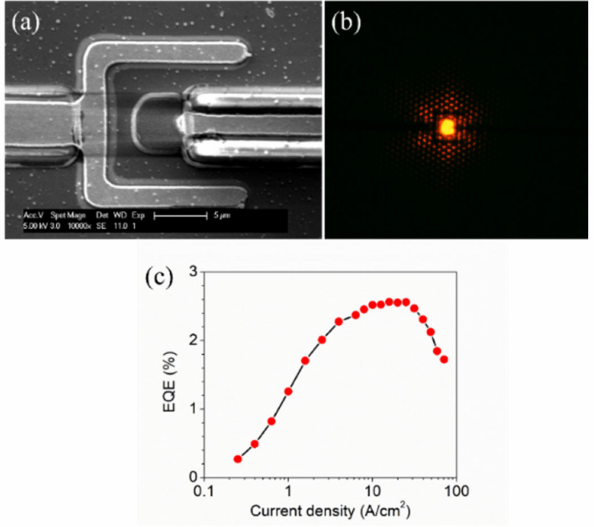
Figure 4. ( a ) SEM image and ( b ) microscope EL image of 5 × 5 µ m 2 µ LED; ( c ) EQE curves. These figures are reproduced from [5], with the permission of AIP